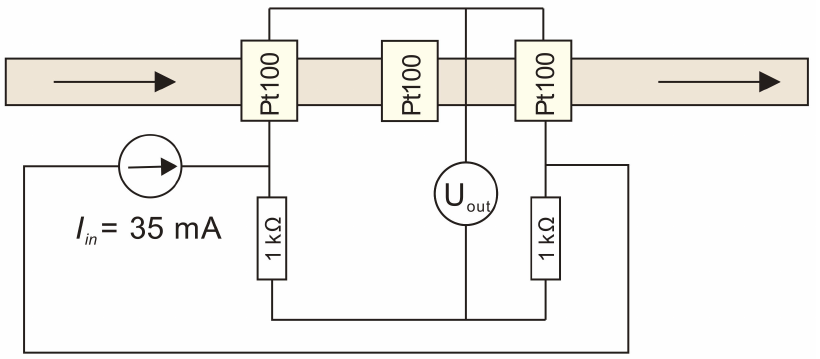
Figure 17. A wiring diagram of a thermal mass flowmeter in the heater/sensor-heater/sensor